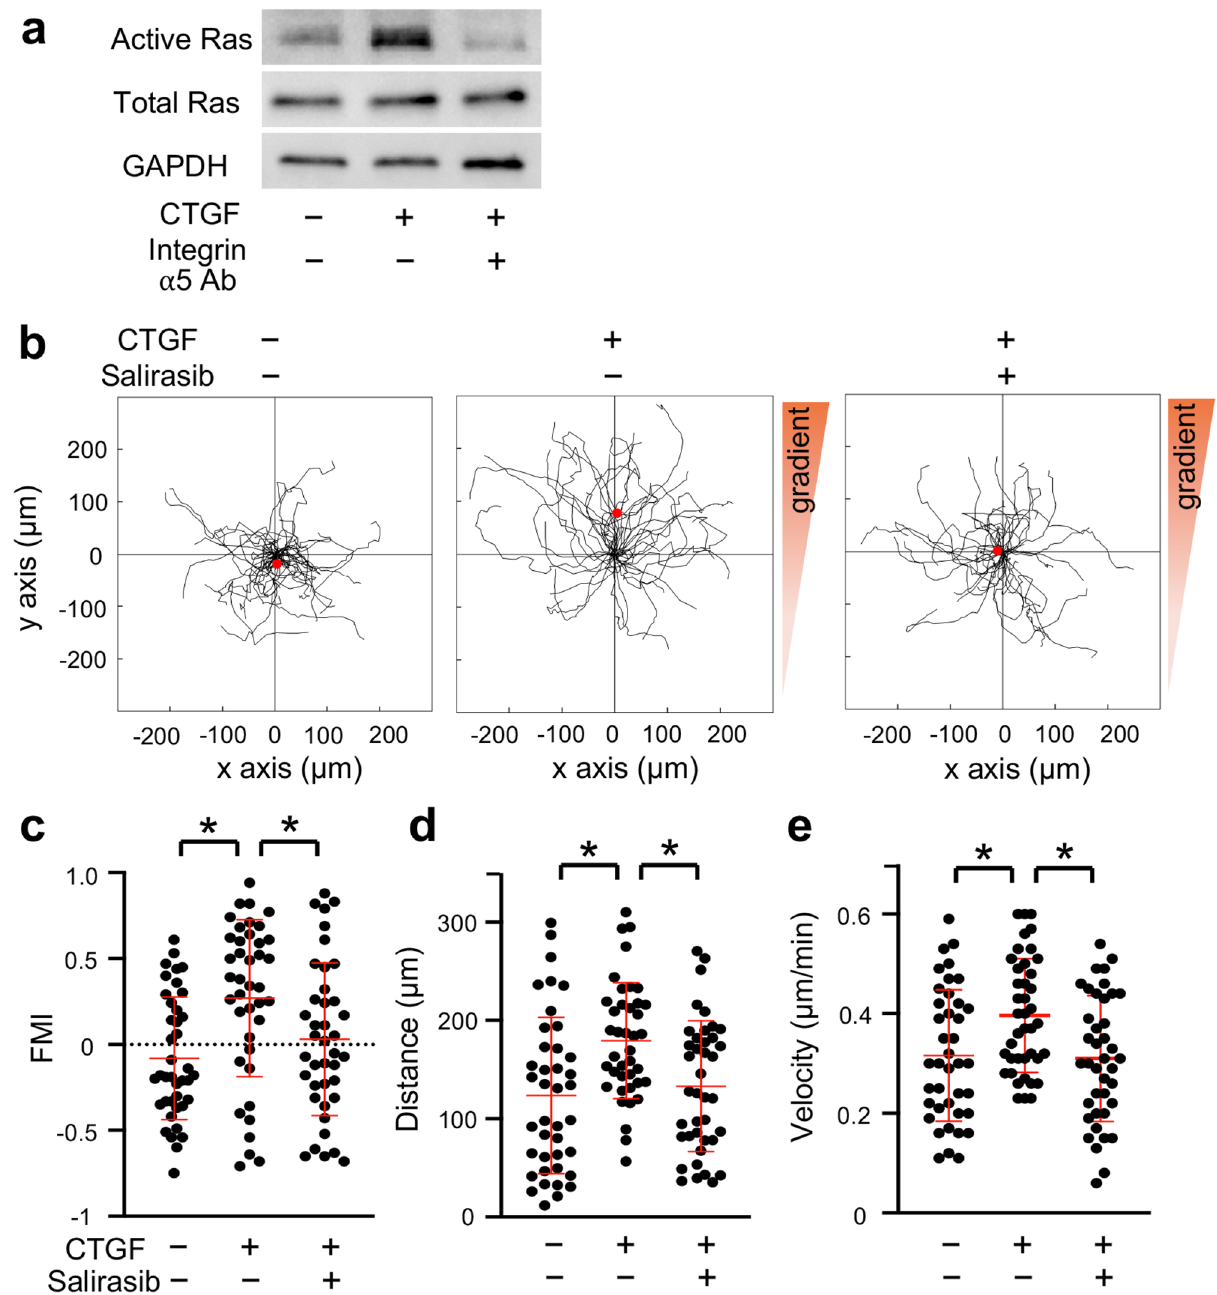
Figure 6. Ras inhibitor suppressed the CTGF-induced chemotaxis of MC3T3-E1 cells. ( a ) MC3T3-E1 cells were seeded onto 10-cm dishes at 45 × 10 4 cells/dish. Next day, the cells were treated with 50 ng/ml CTGF and 5 μg/ml neutralizing integrin α5 antibody for 12 h. Active Ras was analyzed by immunoblotting of pull- down samples from cell lysates. Full-length blots are presented in Supplementary Fig. S4. ( b ) MC3T3-E1 cells were seeded onto an observation area between two reservoirs in a μ-slide chemotaxis chamber and cultured overnight. The cells in the observation area were pretreated with 10 μM salirasib for 1 h. Then 150 ng/ml CTGF with or without 30 μM salirasib was added to one reservoir and the cells allowed to migrate toward CTGF for 12 h. The migration paths of 40 individual cells were analyzed. The red dot represents the center of mass of the endpoints of tracked cells. The parameters FMI ( c ), migration distance ( d ), and velocity ( e ) were determined (n = 40). Integrin α5 Ab = neutralizing integrin α5 antibody. *p < 0.05, ANOVA with Dunn’s post hoc